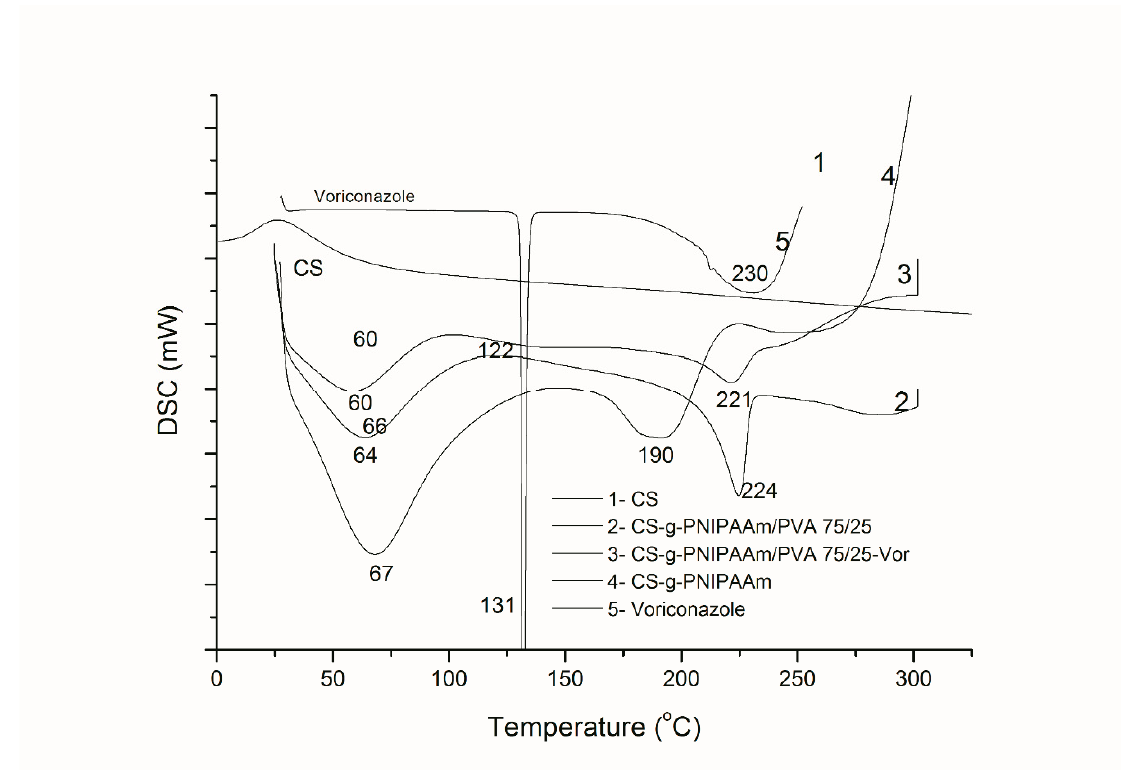
Polymers 2019 , 11 , 1432 ff erential scanning calorimetry (DSC) curves of the hydrogels of CS- g -PNIPAAm. Figure 3 . Differential scanning calorimetry (DSC) curves of the hydrogels of CS - g - PNIPAAm. Figure 3. Di